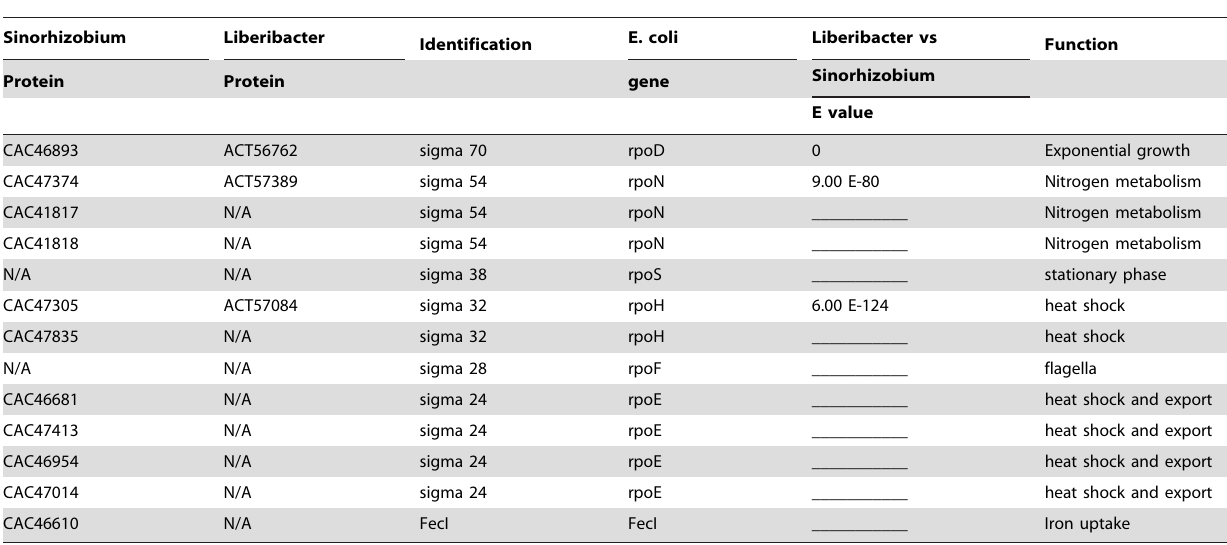
Table 2. Sigma factors present in the genomes of Sinorhizobium meliloti and ‘ Ca . Liberibacter